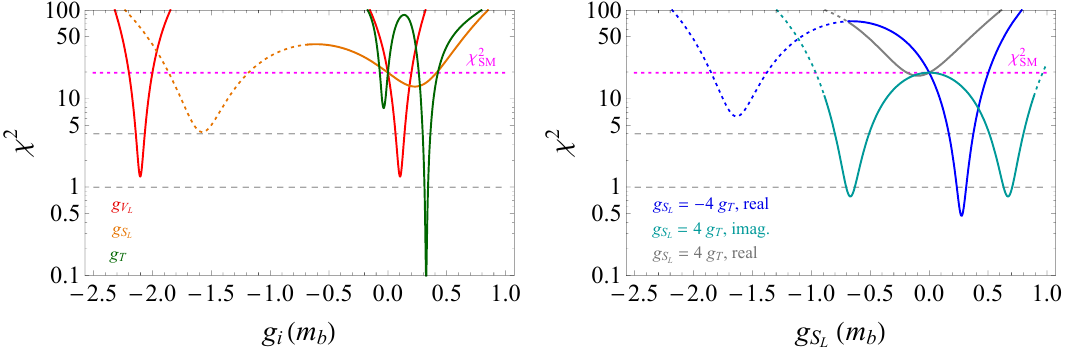
Figure 1: χ 2 values for each individual effective coefficients fits to R pared to the SM value (magenta dotted line). In the left panel, χ 2 is plotted against g , g and g at µ = m . In the right panel, χ 2 is plotted against g V L S L T b = ± 4 g assuming g at µ = 1 TeV, for purely imaginary and real couplings. The S L T dashed portions of the curves correspond to the values excluded by the B